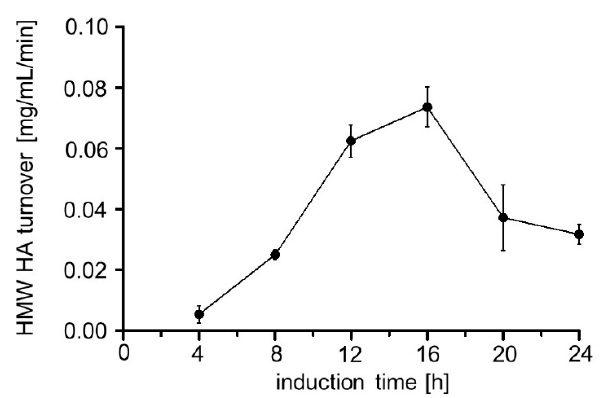
Figure 5. Enzyme activity of Hyal1 on the surface of E. coli F470, dependent upon the induction time. Enzyme activity determination was performed using the Stains-all assay [39]. Cells were cultured and incubated with 1 mM rhamnose for the induction times as indicated. Subsequently OD 578 was set to 10 after washing with sodium formate buffer (100 mM) pH 3.5. hyaluronic acid (HA) was added (0.11 mg/mL final concentration) and reaction was performed for 1 min at 37 °C. Supernatants were analyzed for residual high molecular weight (HMW) HA using Stains-all. Mean values ± SD (n = 3).